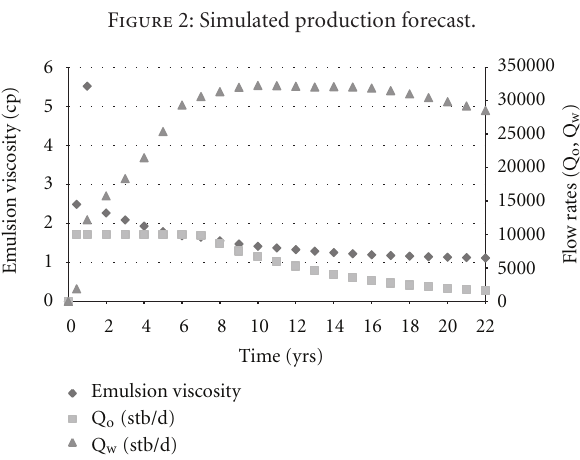
Figure 3: Emulsion viscosity evolution over